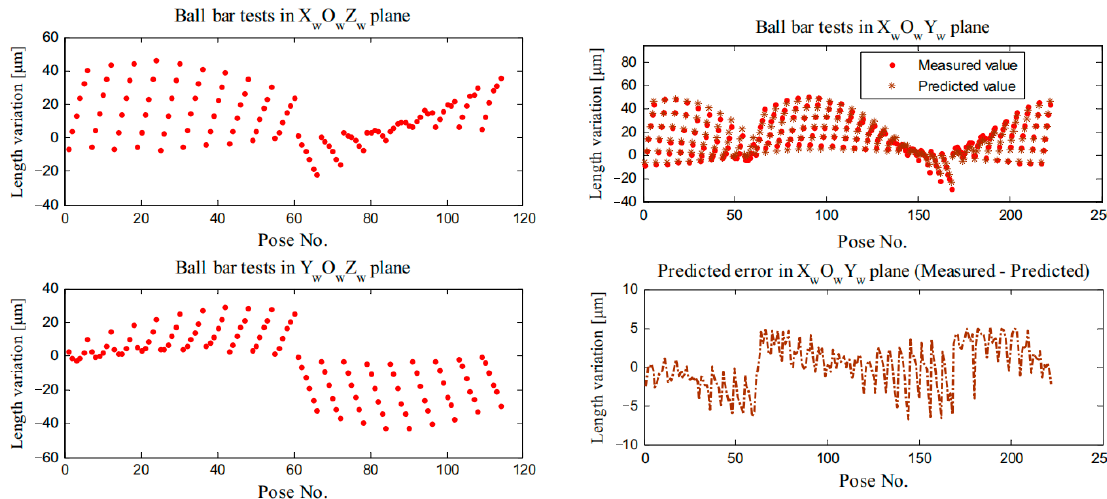
Figure 15. Integrated geometric errors of machining points measured by the ball bar test (2D view). As is shown in Equations (41) and (42), the positions of the tool relative to the B-axis and the workpiece relative to the C-axis, the relative coordinates of (x t , y t , z t ) and (x w , y w , z w ), are the cardinality of geometric error transfer, which indicates that the larger the sizes of the machine tool structures are, the larger the integrated geometric errors